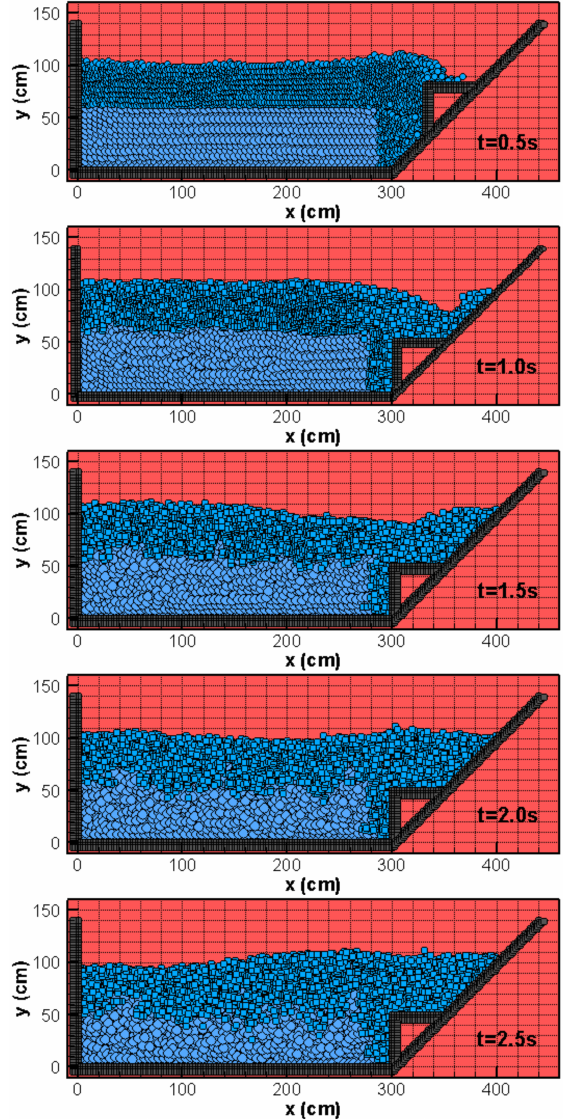
Figure 12. Particle configuration for submarine landslide computed by the MR-WC-MPS method.